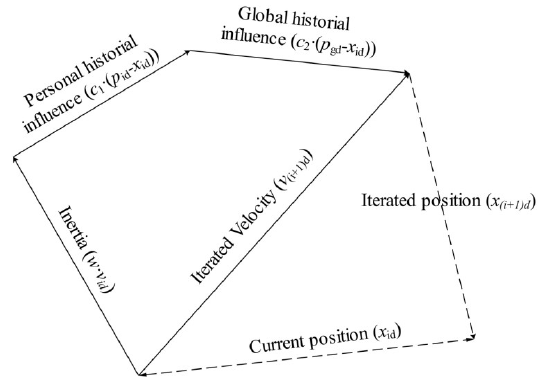
Figure 13. Schematic diagram of Equation